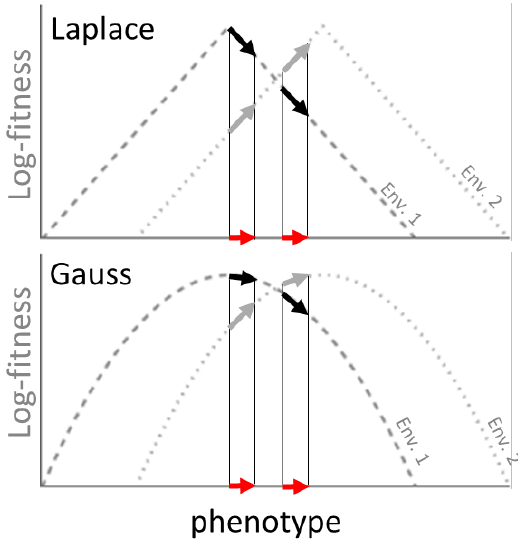
Figure 1 - Laplace and Gauss fitness functions. The red arrow represents a mutation increasing the trait value. With Laplace fitness function, the log-fitness gain of the mutation in environment 2 (gray arrow) is equal to the log-fitness loss in environment 1 (black arrow), irrespectively of the current phenotype (in absence of optimum overshoot). With Gauss fitness function, the log-fitness gains (and losses) depend on current phenotype.